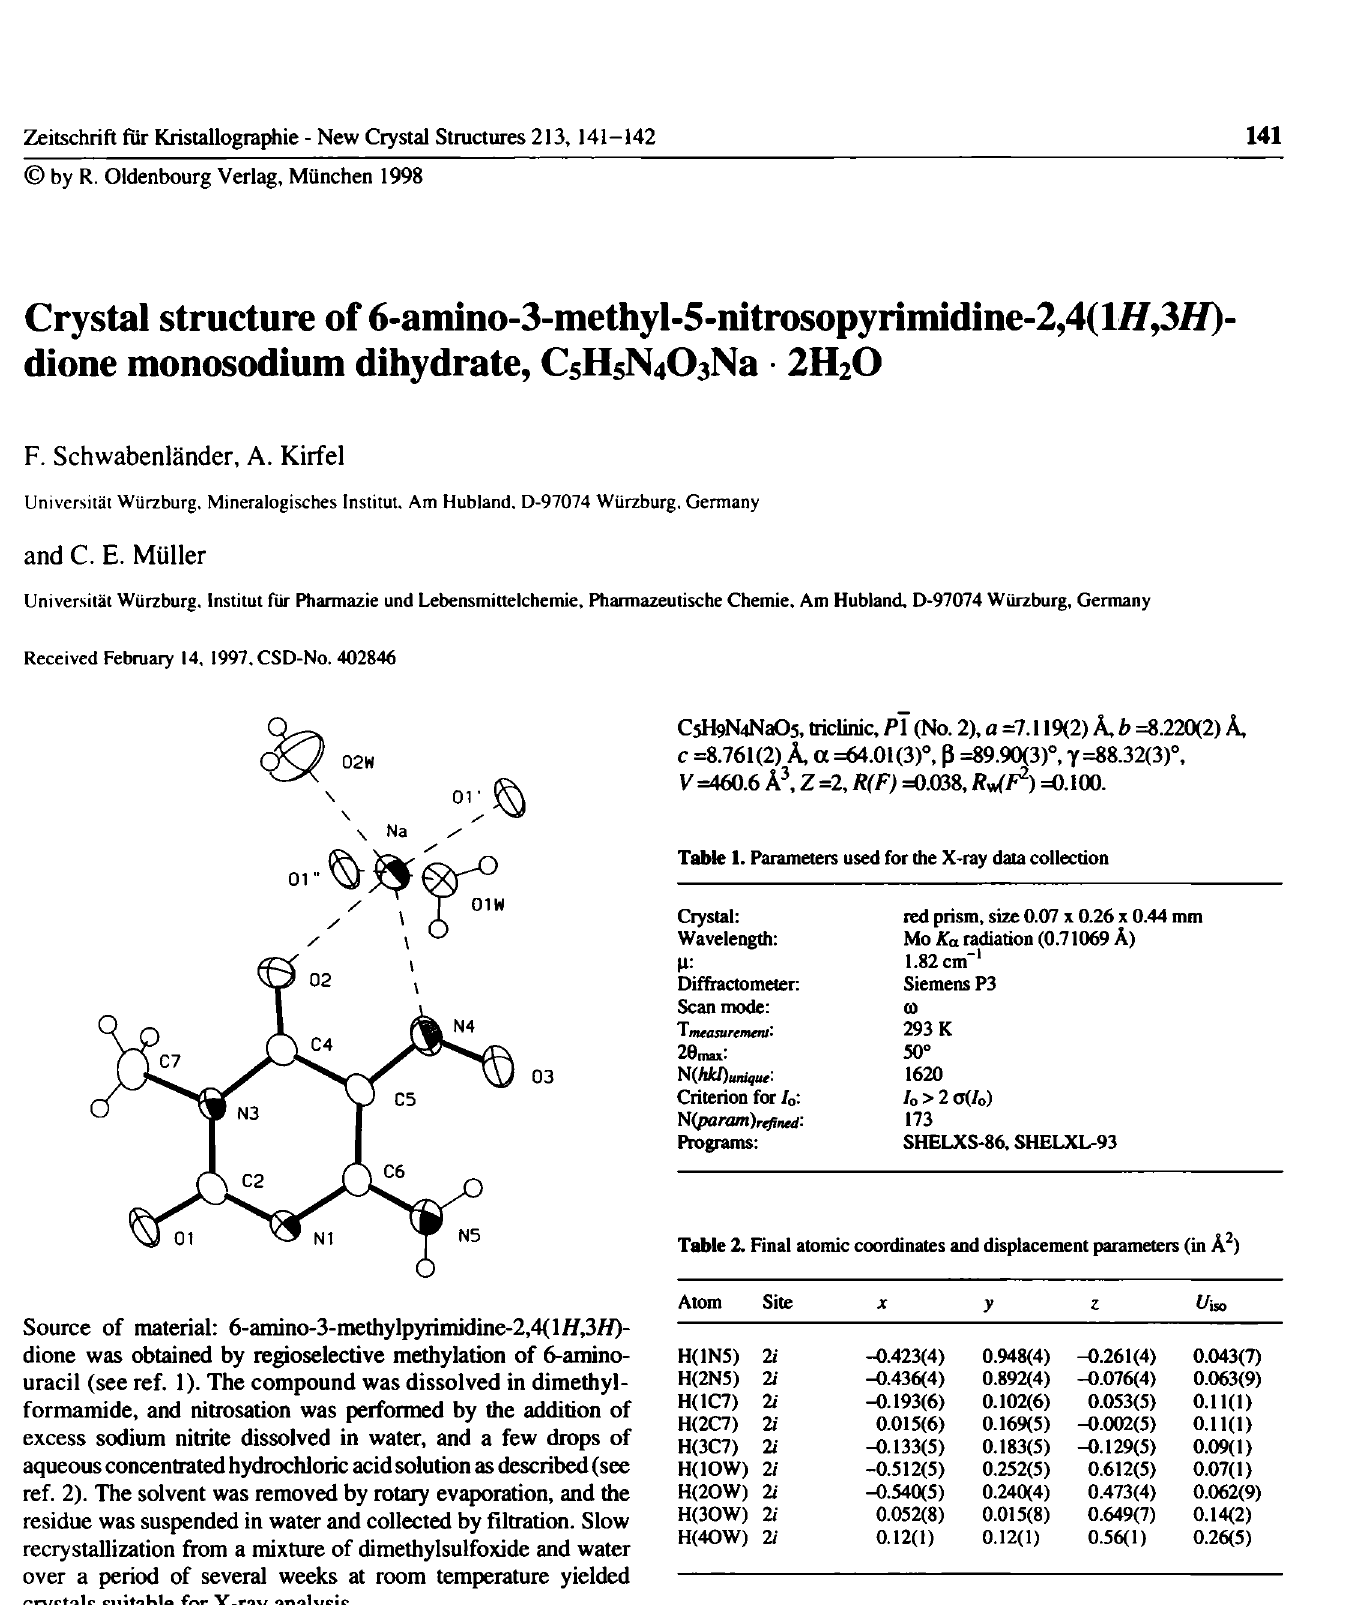
Table 3. Final atomic coordinates and displacement parameters (in